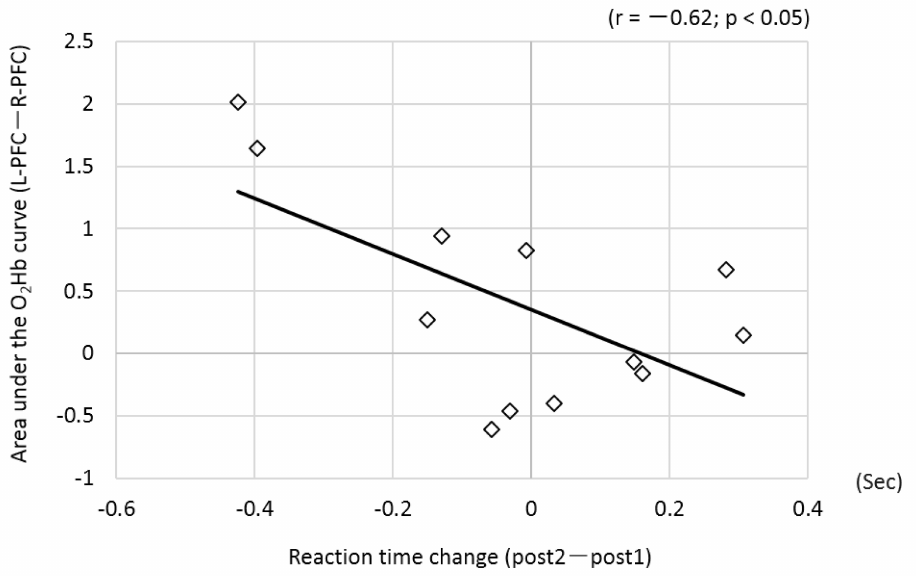
Figure 6. Correlation between the area under the curve (AUC) O 2 Hb and the variation in reaction time. The horizontal axis represents the reaction time, and the vertical axis represents the AUC O 2 Hb. O 2 Hb: oxygenated